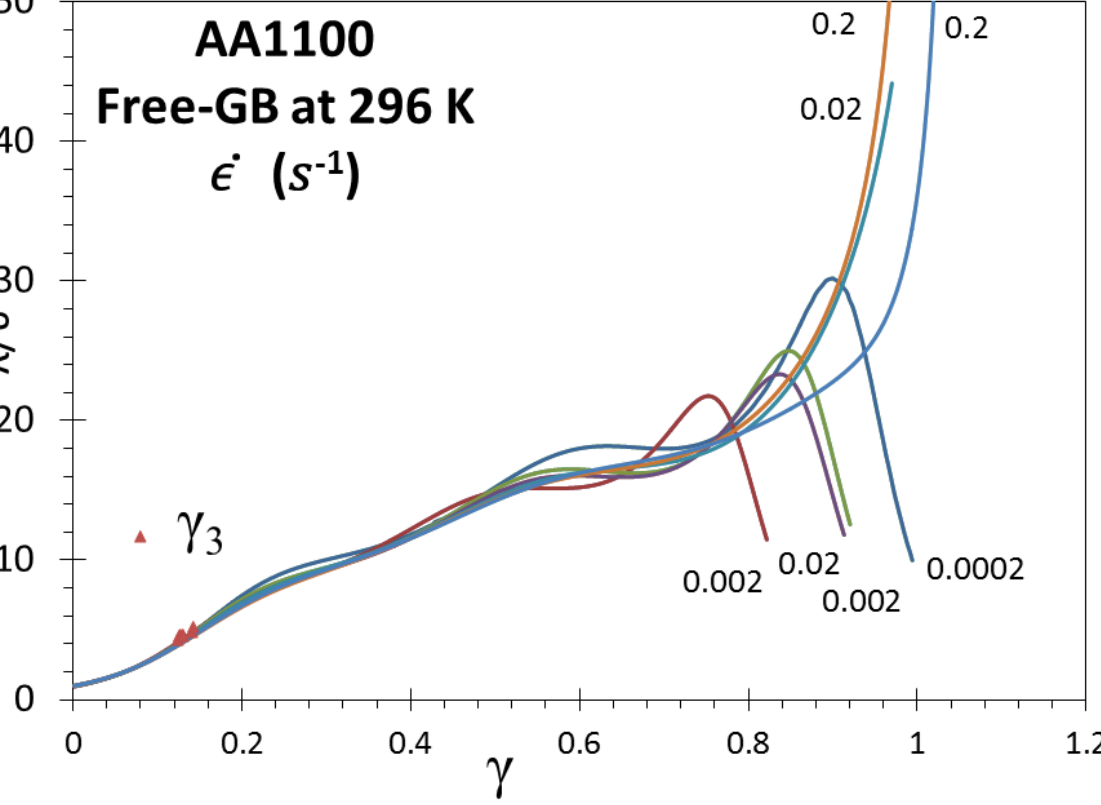
Figure 16. Mean slip distance to obstacle spacing ratio as a function of shear strain for various indicated strain rates (reported in s − 1 ). The denoted γ 3 correspond to strain at σ 3 . For kinetic analyses, the shear stresses and mean slip velocities at the peak locations are used to obtain activation energies which correspond to vacancy migration energy [40].